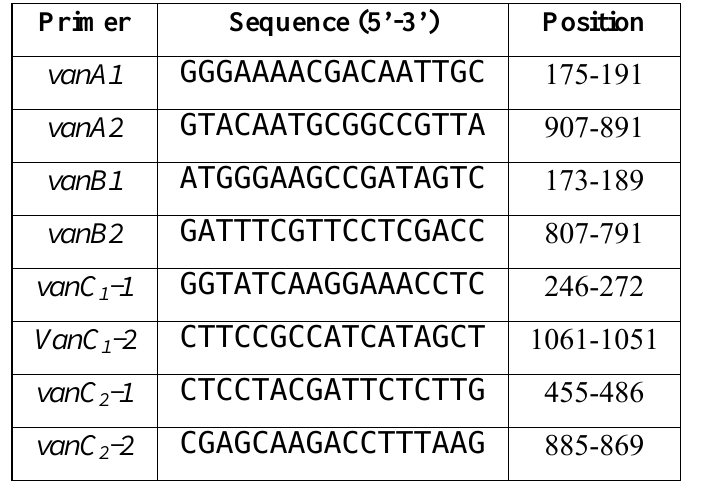
Table 7. The sequences of the van gene PCR